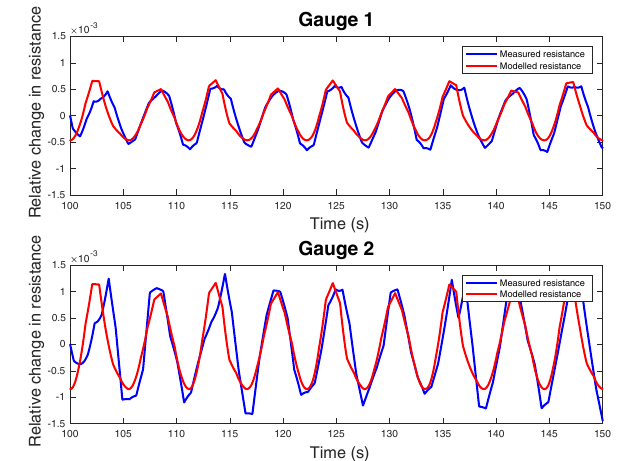
Figure 16. Comparison of measured (blue) and modelled (red) re- sponse of the two printed strain gauges after high-pass filtering (Eijking et al., 2017).